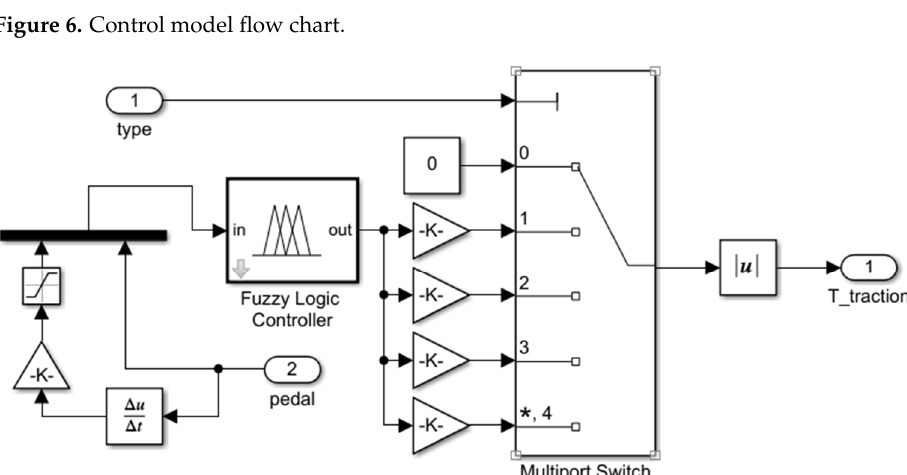
Figure 7. Traction demand torque model.